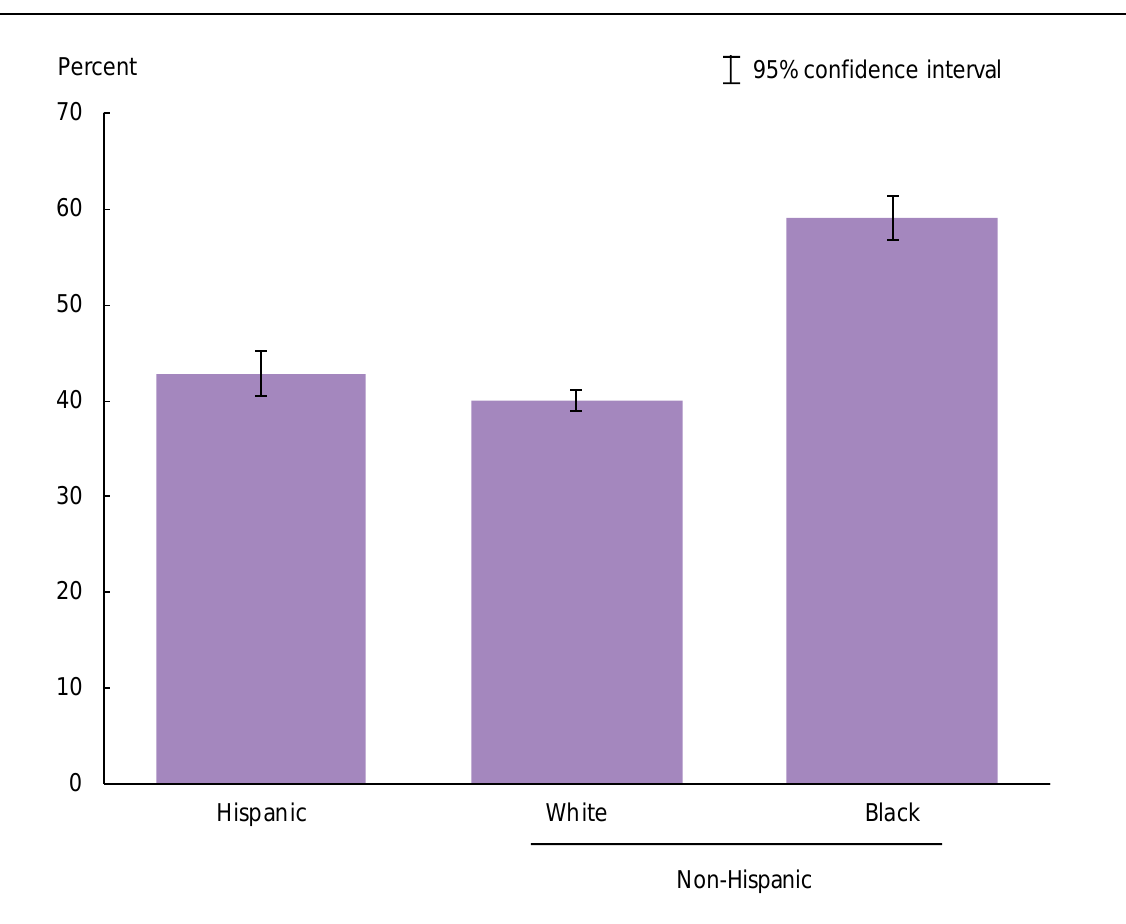
Figure 10.3. Age-sex-adjusted percentage of adults aged 18 and over who had ever been tested for HIV, by race and ethnicity: United States,